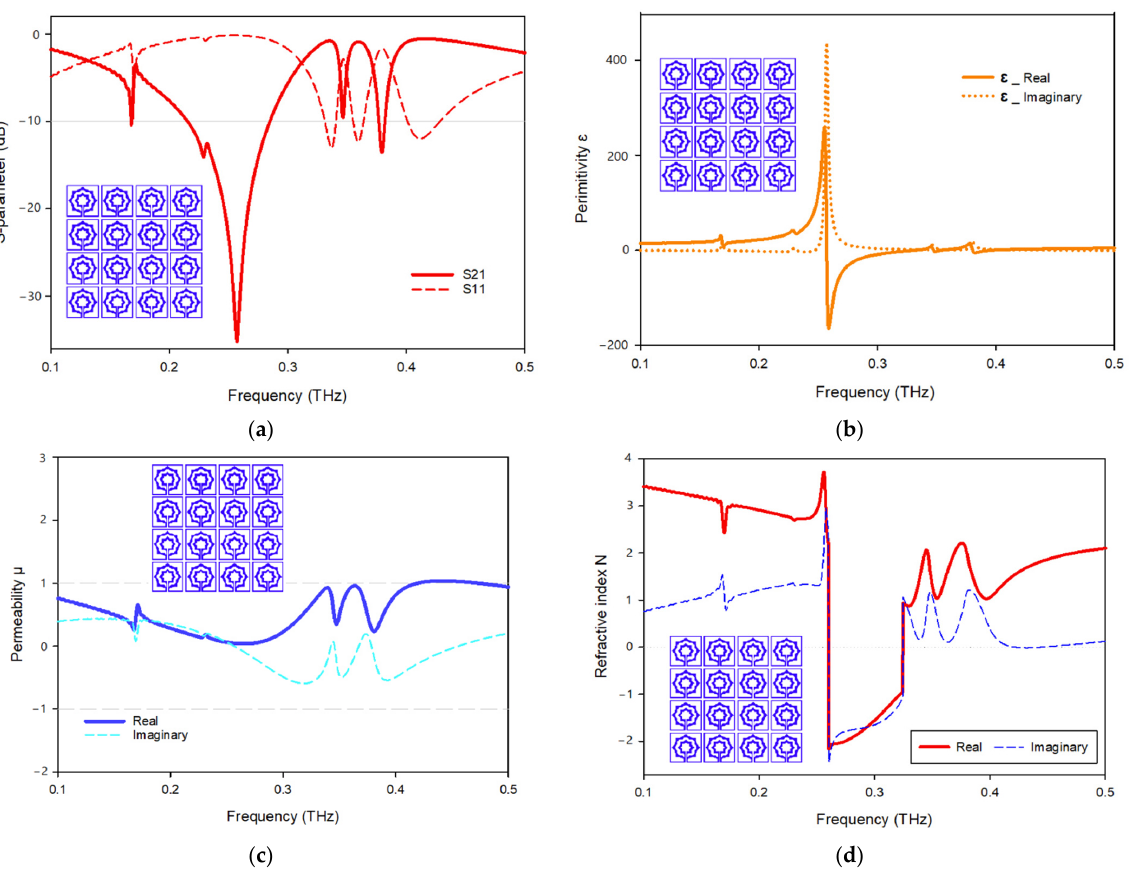
Figure 16. Effective parameters of the 4 × 4 array structure: ( a ) scattering parameters; ( b ) permittivity; ( c ) permeability; ( d ) refractive index.